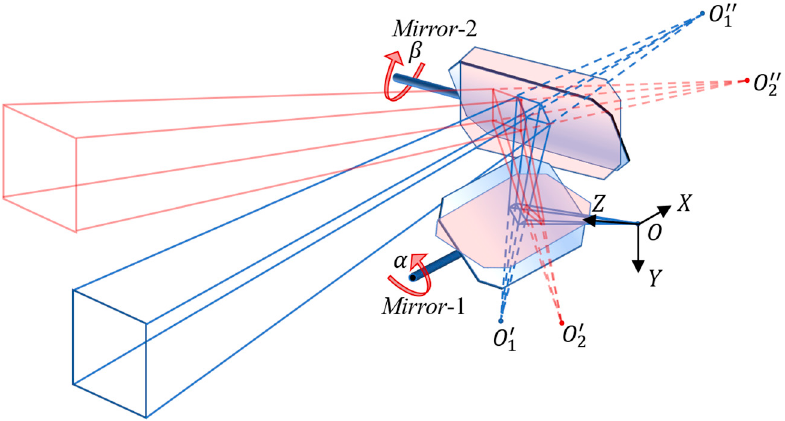
Figure 2. The virtual camera pose transformed by specular re fl ection transformation.